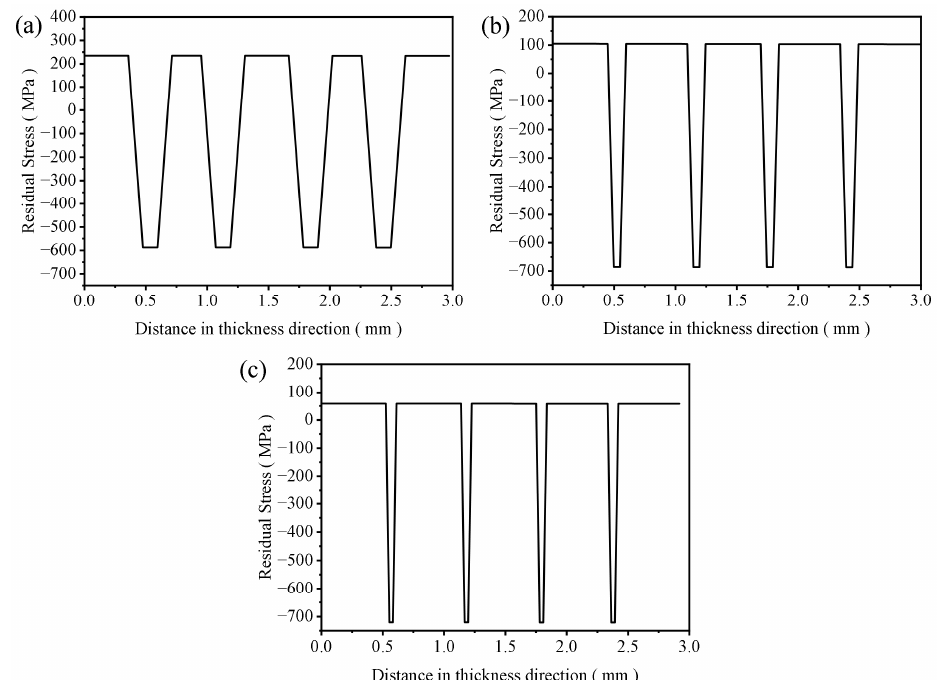
Figure 6. Stress distribution in the Y-direction of different layer thickness ratio models (( a ) R = 2, ( b ) R = 5, and ( c ) R = 10).